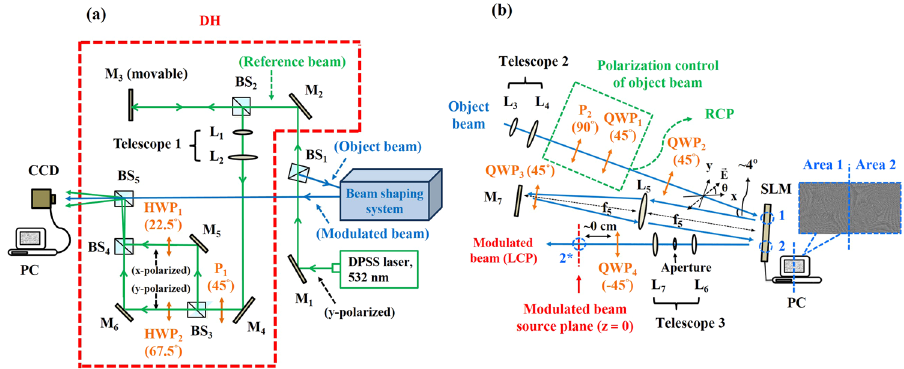
Figure 1. ( a ) Experimental setup of the imitated q-plate beam shaping system combined with DH. ( b ) Detailed schematic of the imitated q-plate system arrangement. L: lens, P: polarizer, HWP: half-wave plate, QWP: quarter-wave plate, M: mirror, BS: non-polarizing beam splitter with 50:50 split ratio. All the orientation angles of the slow (optical) axis of wave plates and the transmission axis of polarizers with respect to the x-axis are also given in the figure. The inset at the right-top corner of ( b ) shows an example of simultaneously displaying two blazed holograms side by side on the SLM. The distance between the modulated beam source plane, denoted as plane 2 * , and the CCD plane is about 24